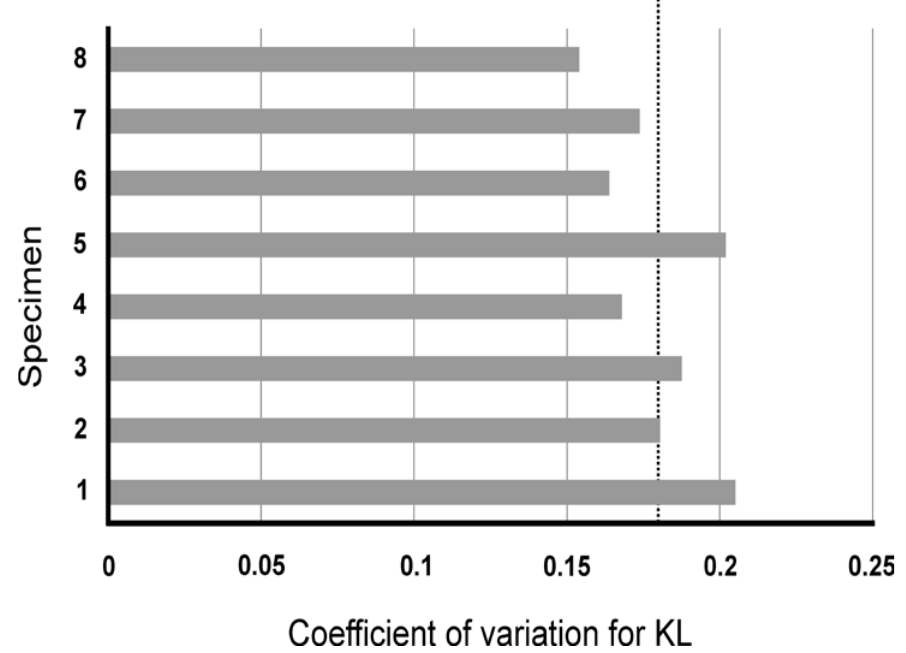
Figure 2. Coefficient of variation (CV) of karyotype length. CVs for karyotype length of the specimens of Cephalotes pusillus measured. The dash line represents the mean